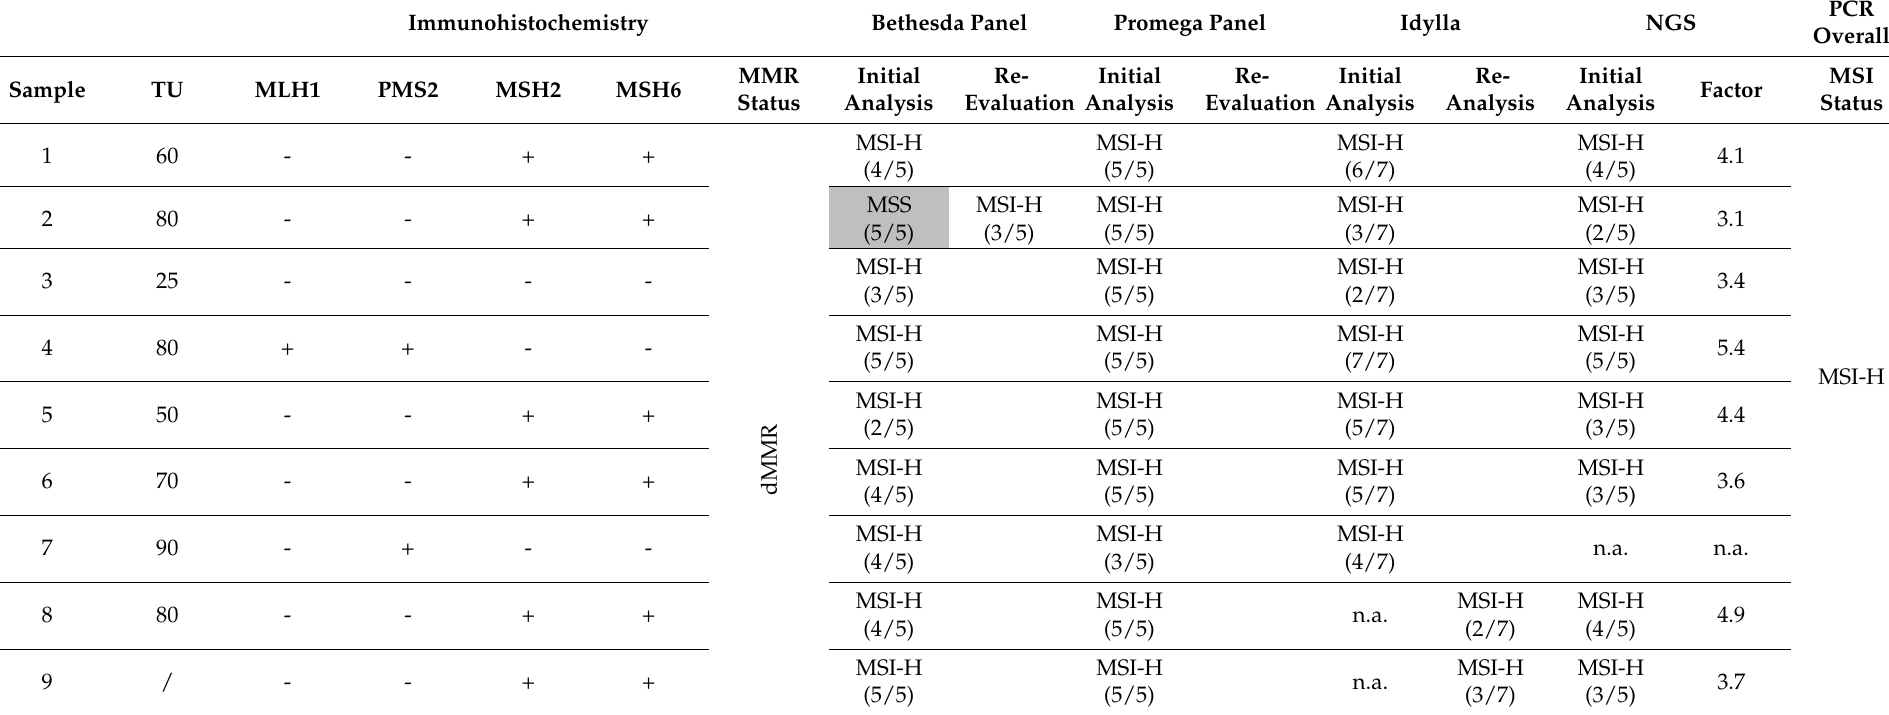
Table 1. Overview of mismatch repair (MMR) and microsatellite instability (MSI) status of cohort one after initial testing and re-analysis of four PCR-based testing methods including an in-house Bethesda panel, Promega panel, Idylla system and next generation sequencing (NGS) (customized GeneRead V2 panel). For re-analysis of the Idylla system, extracted DNA was